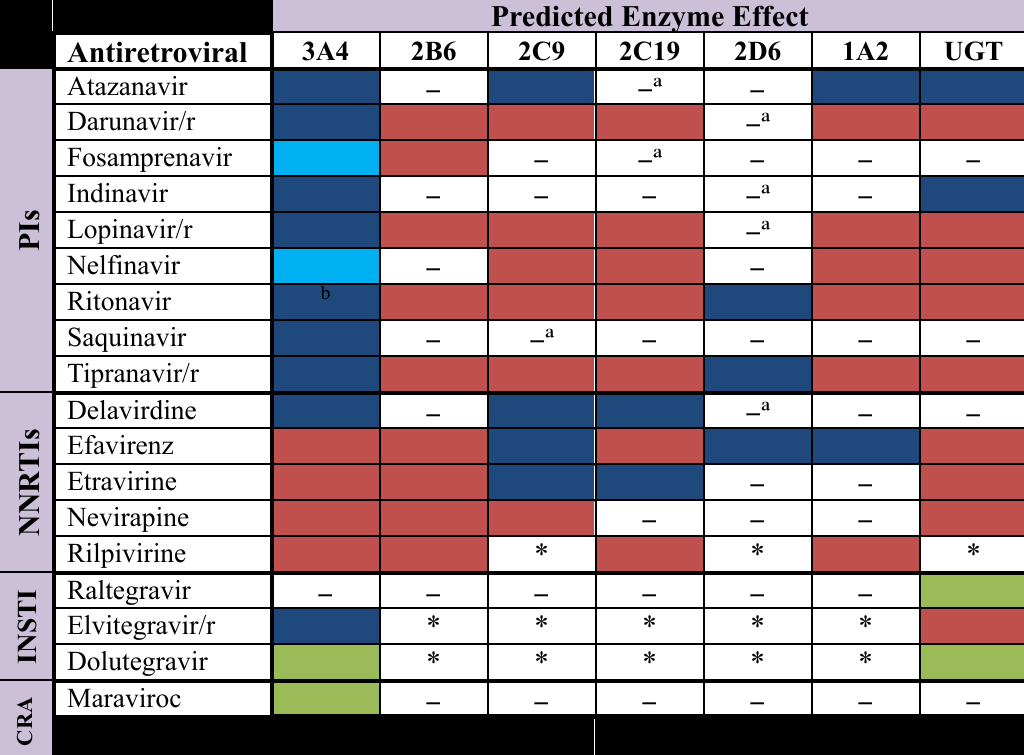
Table 1. Metabolic Effects for Antiretrovirals